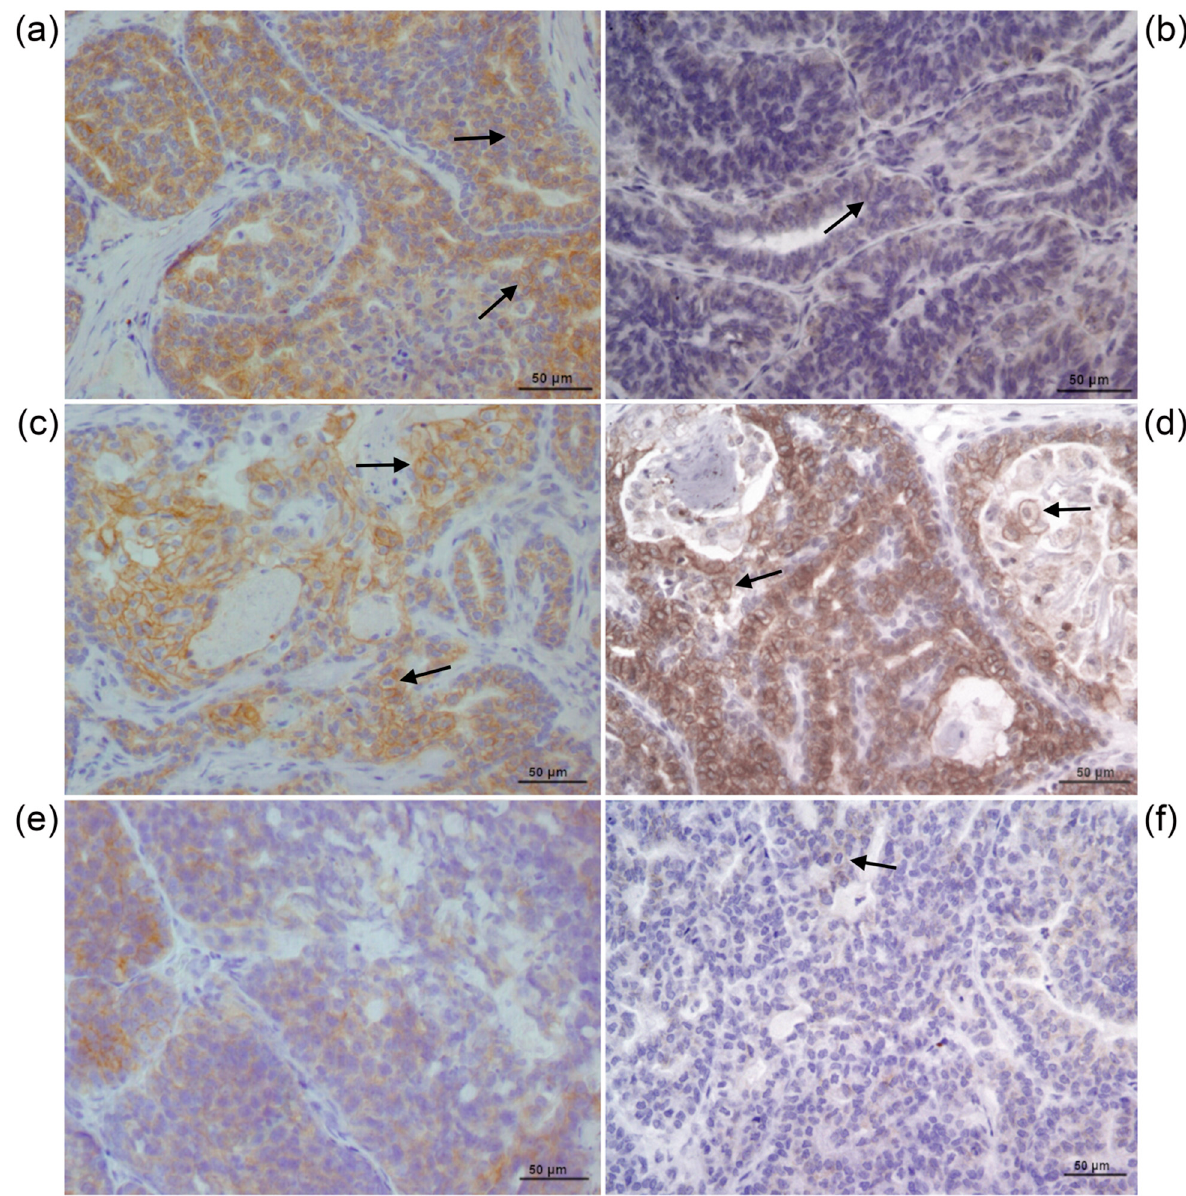
Figure 1. Immunohistochemical analysis of HER2 in samples of canine mammary carcinoma. Cell membrane staining indicates a positive cell for HER2 expression (arrows). ( a ) UNESP-CM1; ( b ) UNESP-CM5; ( c ) UNESP-CM9; ( d ) UNESP- CM60; ( e ) UNESP-MM1; ( f ) UNESP-MM4.